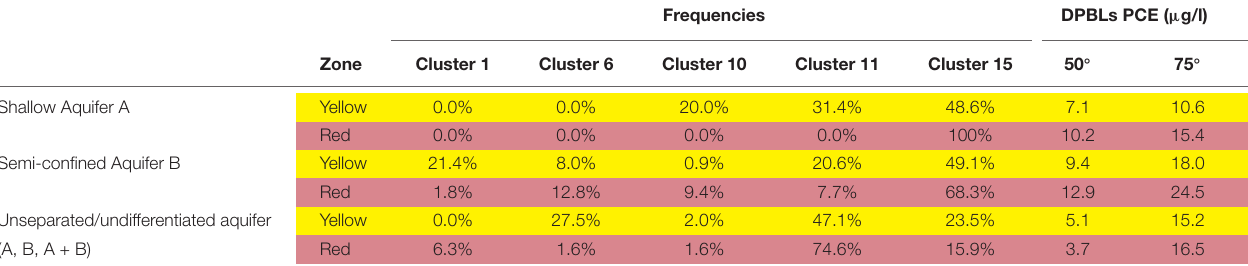
TABLE 4 | DPBLs ranges for PCE for the 2 separated Aquifers and the unseparated one in NW sector of Milano FUA.